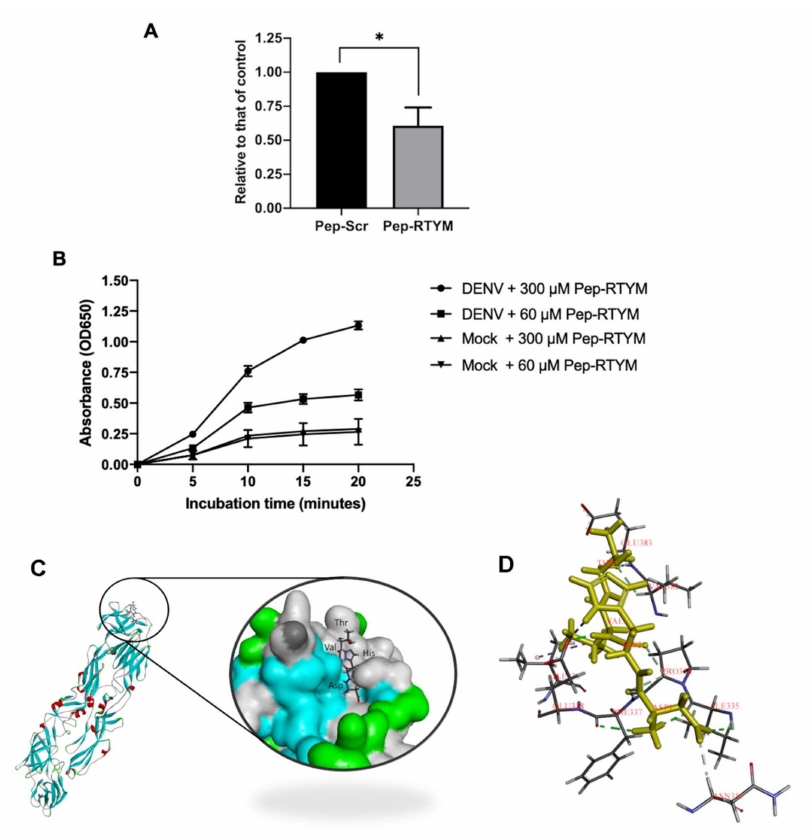
Figure 4. Mechanism of peptide inhibitor on inhibiting DENV infection. The ability of Pep-RTYM to inhibit virus entry was determined using real-time quantitative reverse transcription polymerase chain reactions. The internalized virus particles were measured in DENV-infected cells with 25 µ M Pep-RTYM treatment compared to that of Pep-Scr treatment ( A ). The dose-dependent capacity of Pep-RTYM to directly interact to the virus particle was analyzed by peptide-virus binding assay ( B ). The molecular docking showed the interaction of Pep-RTYM (yellow) to DENV EDIII protein ( C ). The predicted biding residues of Pep-RTYM (yellow) and EDIII were labeled ( D ). Asterisks were used to indicate di ff erent levels of statistical significance, as follows: * p <